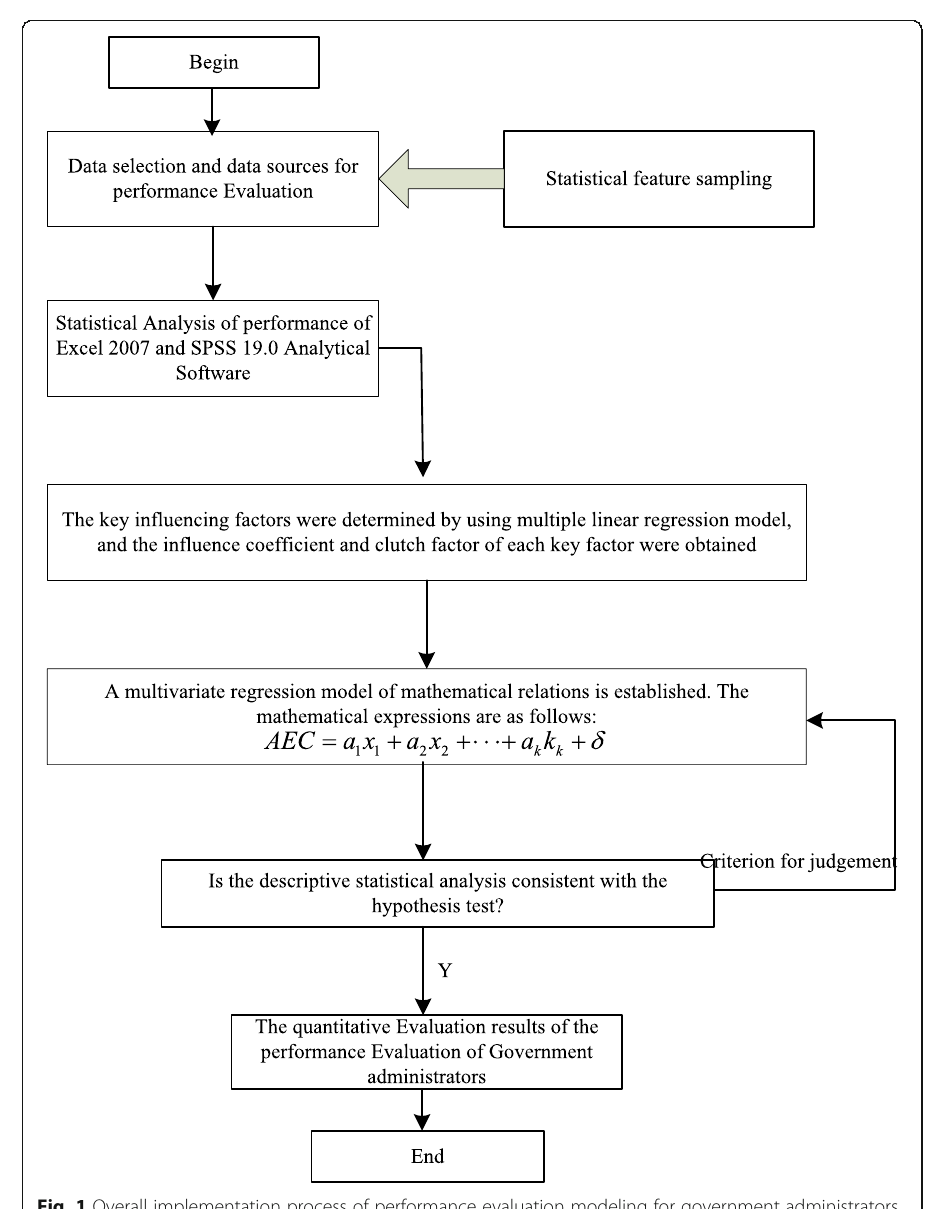
Fig. 1 Overall implementation process of performance evaluation modeling for government administrators based on